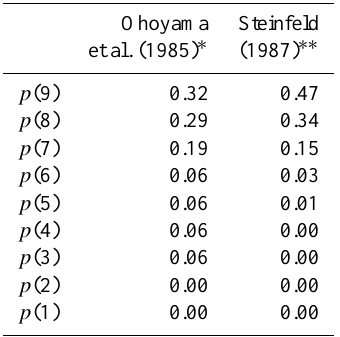
Table 3. Nascent vibrational level distributions used for model sim-